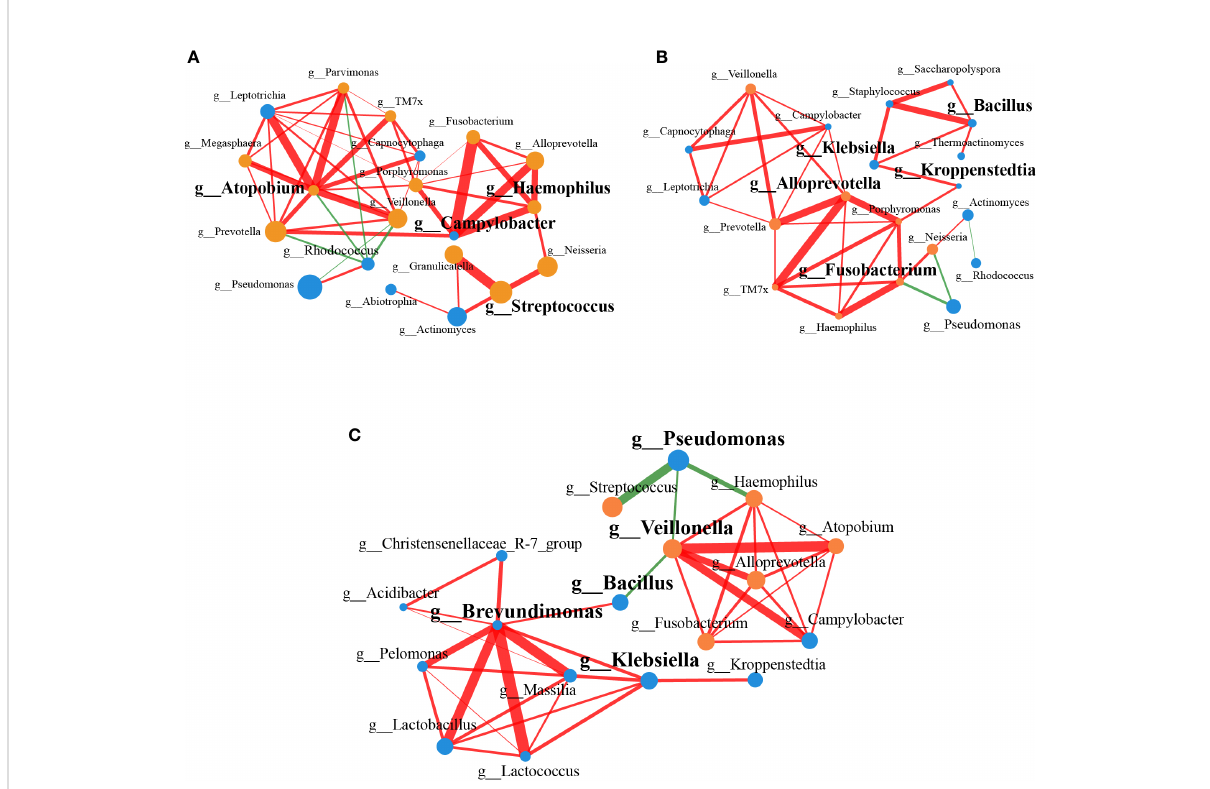
FIGURE 3 Correlation networks of genus associated with LC. (A) The correlation network between genera in LC patients (n=20). (B) The correlation network between genera in controls (n=20). (C) The correlation network based on the signi fi cantly different genera found by 16S rRNA amplicon sequencing (n=18, P < 0.05). The color of the nodes represented different groups, with nodes of the same color belonging to the same group. The yellow nodes represented LC group, and the blue nodes represented controls. The size of the nodes indicated the mean abundance of the genera in samples within the group. Edges between nodes represented the correlation between the abundance of two genera. Red lines represented positive correlations, while green lines represented negative correlations. The widths of the edges were proportional to the correlation strength, and wide line indicated stronger